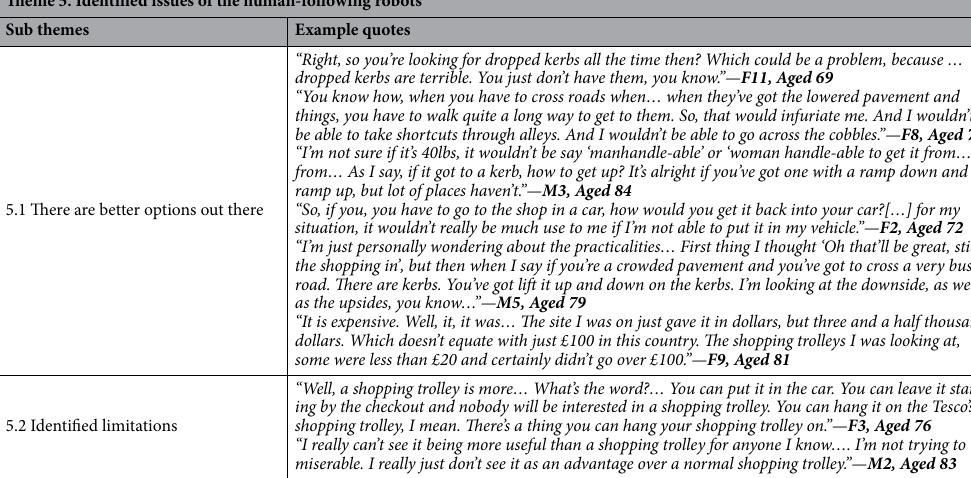
Table 6. Example quotes Identified issues of the human-following